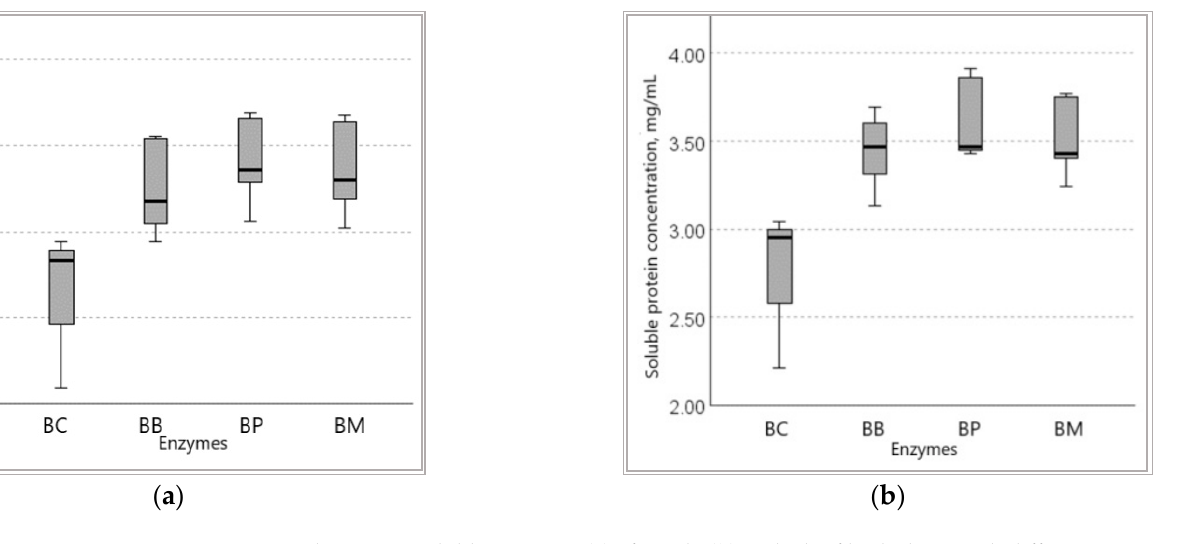
Figure 3. Changes in soluble proteins: ( a ) after 2 h; ( b ) and 4 h of hydrolysis with different enzymes for all bran samples tested (BC, control bran sample; BB, bran treated with bromelain; BP, bran treated with papain; BM, bran treated with a combination of bromelain and papain).